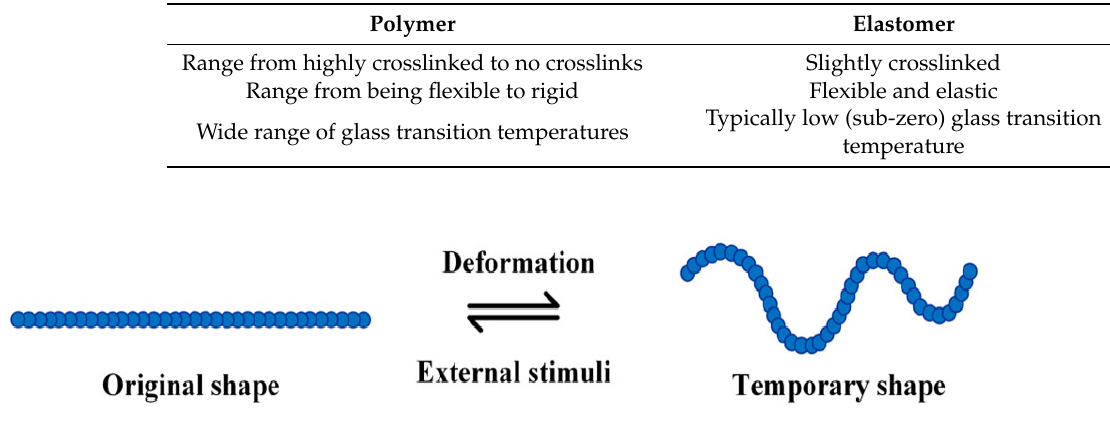
Figure 1. Characteristic behaviour of shape memory elastomers: (i) deformation of the material transforms the original ‘equilibrium’ shape into a temporary shape, and (ii) external stimuli trigger and affect the return to the original shape from the temporary shape.